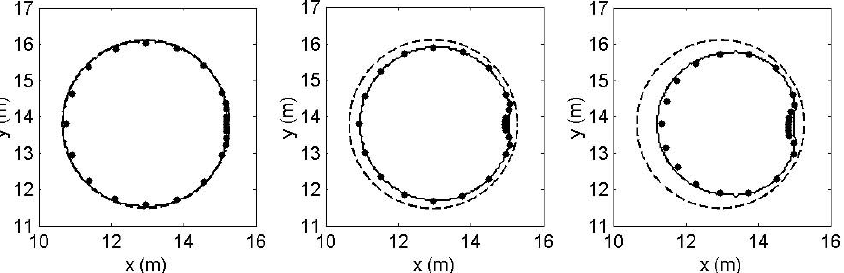
Fig. 13. Maximum inundation on the conical island: measured in experiments ( (cid:5) ) and simulated in inner grid (—). Dashed circles depict the initial shorelines. Initial wave heights are A/h =0.041, 0.088 and 0.181 in columns from left to